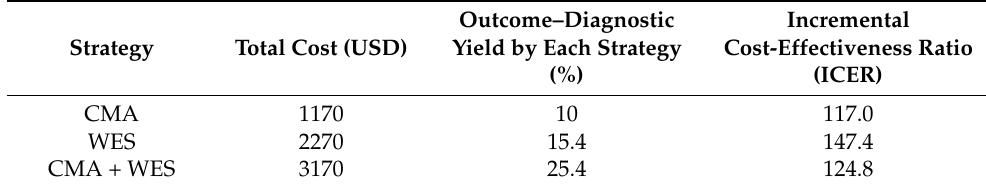
Table 3. Cost-effective analysis of different genetic diagnosis